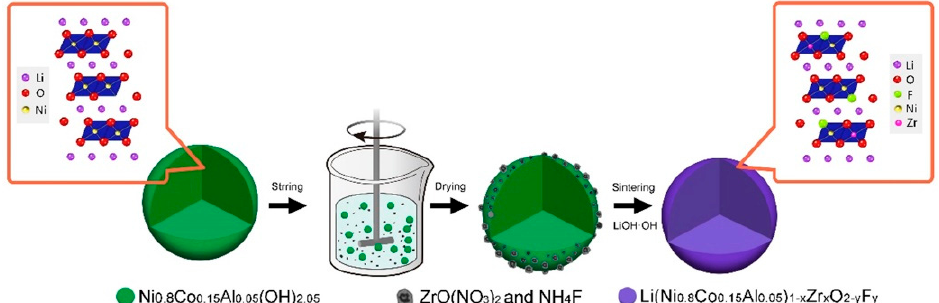
Figure 3. Synthesis schematic diagram of Li(Ni 0.80 Co 0.15 Al 0.05 ) 1 − x Zr x O 2-y F y . Reproduced with permission from [86]. Copyright 2019 Elsevier.